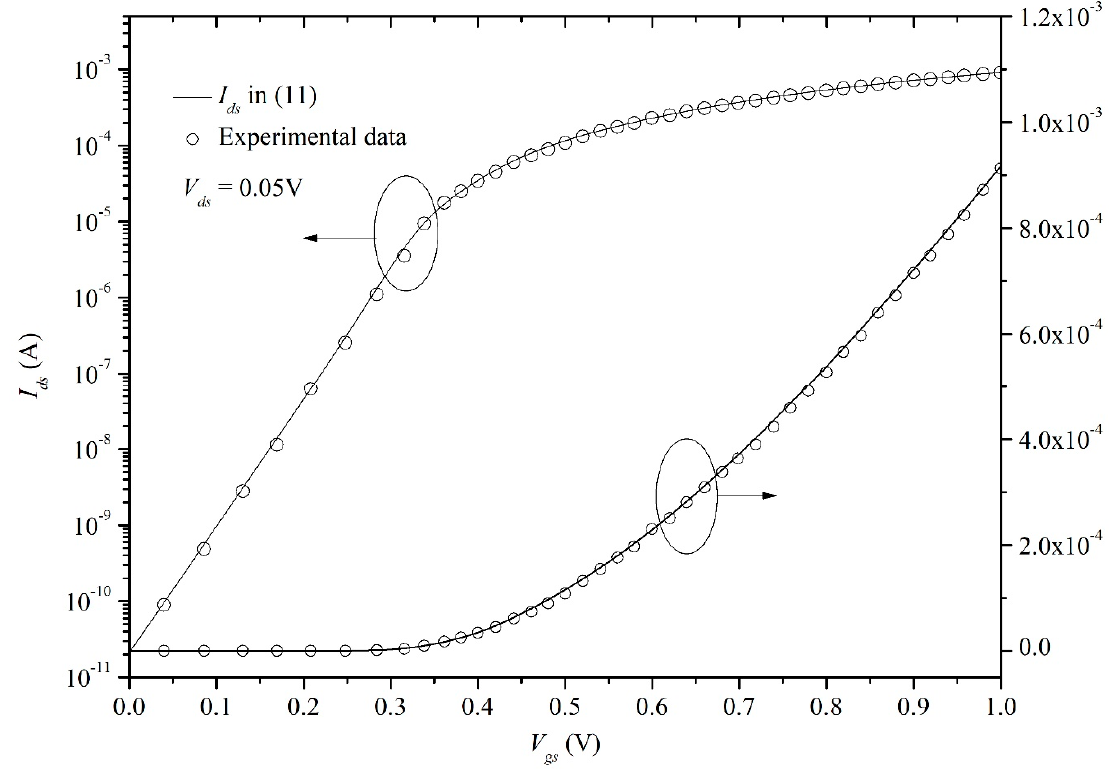
Figure 5. Comparisons of output characteristics between our drain current model results and long-channel experimental data [22] from Khandelwal et al.